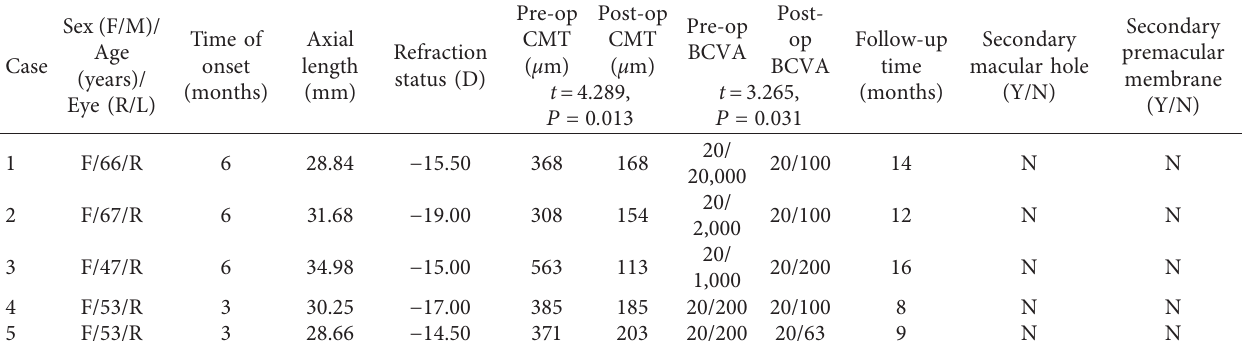
Table 1: Clinical characteristics of